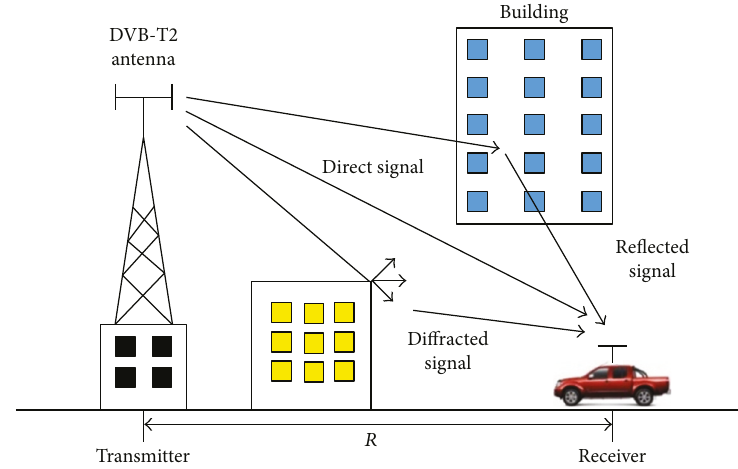
Figure 1: Measurement model for path loss in urban channel propagation.